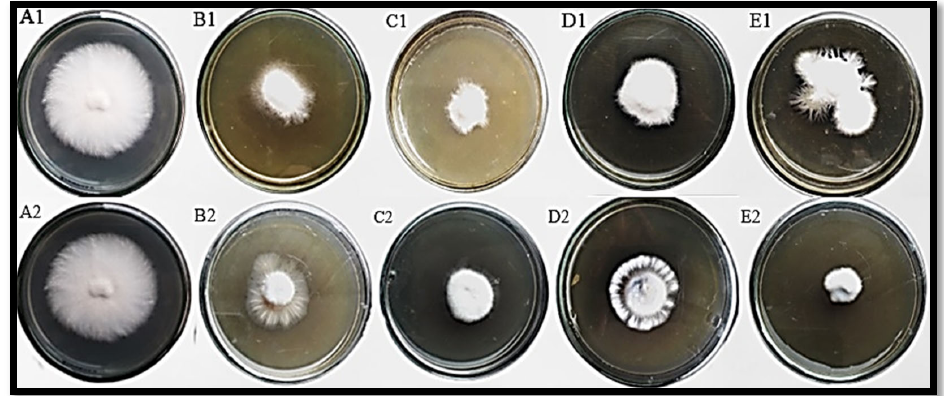
Figure 10. Antagonism of F. oxysporum under various concentration of ZnO NPs and chemical fungicides, in vitro. ( A1 ) Control, ( B1 ) 0.25 µ g/mL ZnO NPs, ( C1 ) 0.50 µ g/mL ZnO NPs, ( D1 ) 0.75 µ g/mL ZnO NPs, ( E1 ) 1.0 µ g/mL ZnO NPs, ( A2 ) control, ( B2 ) 0.25 µ g/mlL metalaxyl + mancozeb fungicide, ( C2 ) 0.50 µ g/mL metalaxyl + mancozeb fungicide, ( D2 ) 0.75 µ g/mL metalaxyl + mancozeb fungicide, ( E2 ) 1.0 µ g/mL metalaxyl + mancozeb fungicide. Table 1. Percentage growth inhibition of F. oxysporum under various concentrations of ZnO NPs and metalaxyl + mancozeb fungicide. Concentration ZnO NPs % Inhibition Metalaxyl + Mancozeb Fungicide % Inhibition 0.25 µ g/mL 78.0 ± 0.5 64.1 ± 0.5